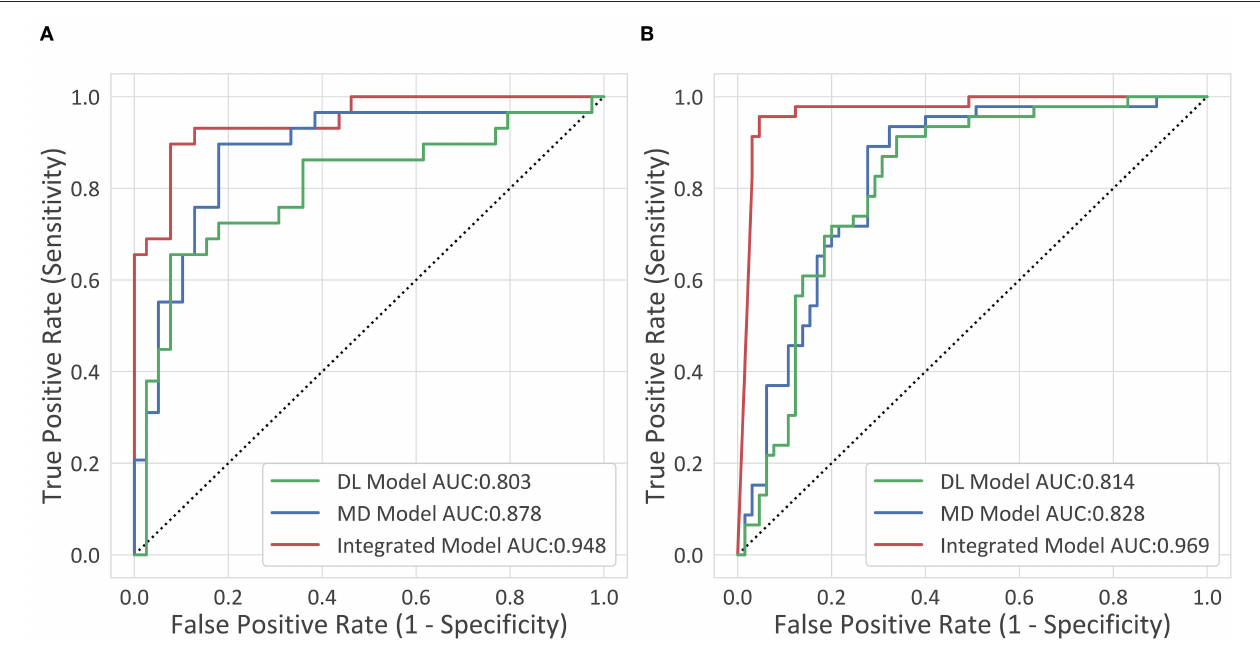
FIGURE 3 | The receiver operating characteristic (ROC) curves. (A) The internal testing cohort. (B) The external testing